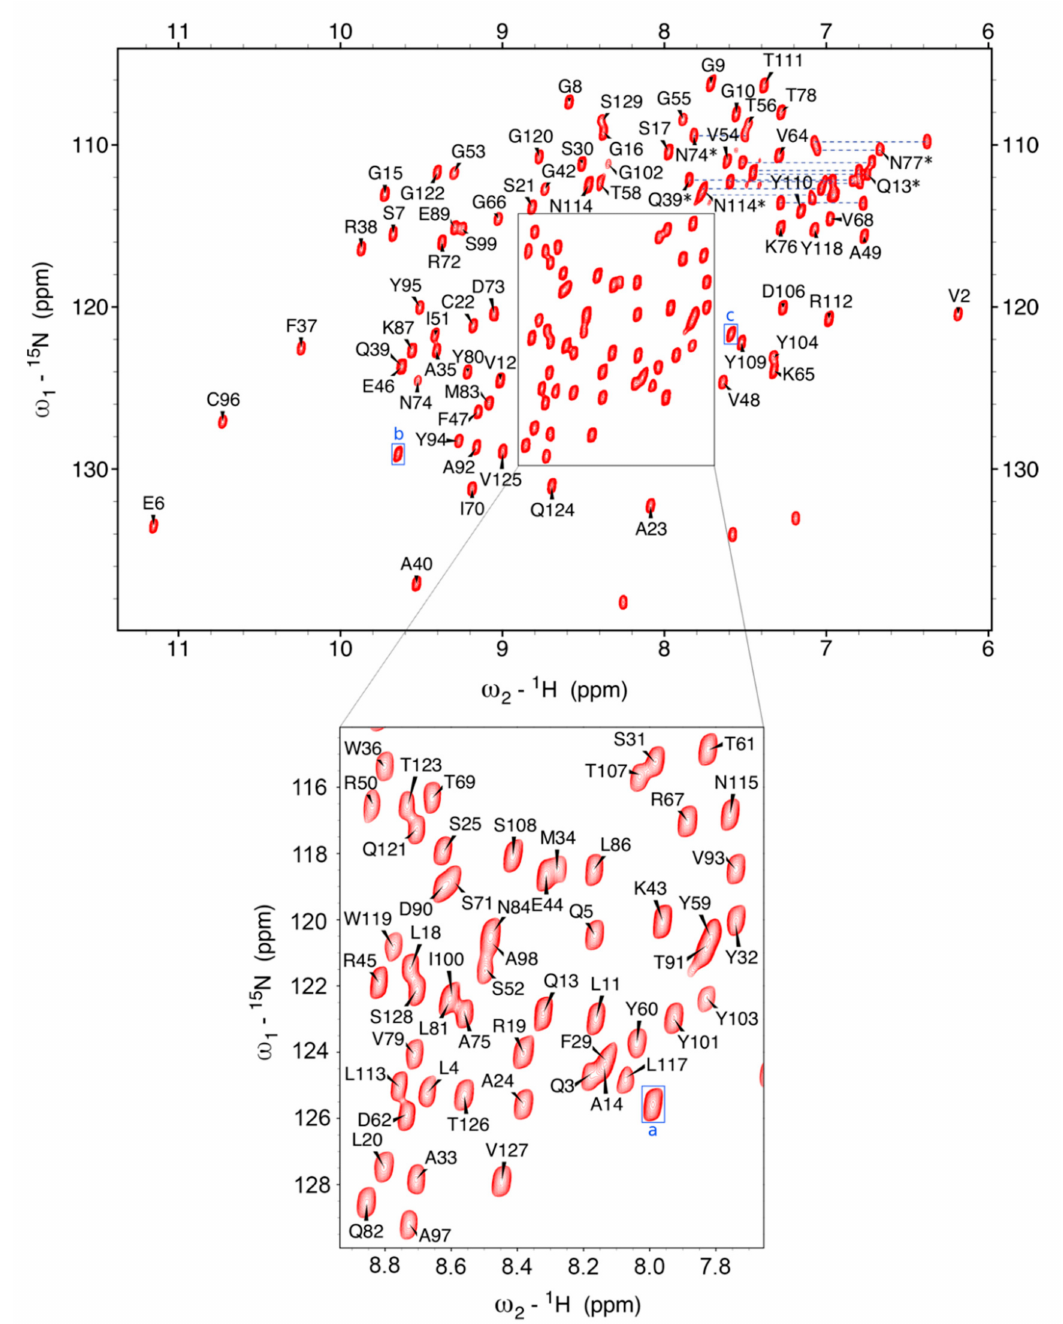
Figure 1. The 15 N − 1 H HSQC of Nb23 from a freshly prepared sample (247 µ M in 19.5 mM bis-Tris and 21 mM NaCl). The good signal − to − noise of the spectrum allowed the application of a squared sine − bell shifted by π /6 to achieve complete resolution. Excluding Met0 and the C − terminal (His) 6 tag used for expression, five N − H connectivities could not be assigned (Gln1, Arg27, Thr28, Ser63, and Ser105). Only the three blue-boxed connectivities, labeled a, b, and c, out of those that were observed, could not be attributed through scalar correlation. A tentative assignment is proposed based on heteronuclear NOE (see main text). The central area highlighted with a box has been enlarged for better visualization (lower panel) to limit the assignment annotation crowding given the high density of peaks. The Asn and Gln sidechain carboxyamide pairs could be connected from the slow exchange cross − peak of 2D 1 H − 1 H NOESY, which also enabled the identification in a few cases from intra − residue NOE. The pairs are connected with blue dashed lines and the assigned ones are marked with an asterisk. The dispersion of peaks indicates a well − structured protein. The remaining peaks without labels belong to sidechain NHs, i.e., Arg, His, and